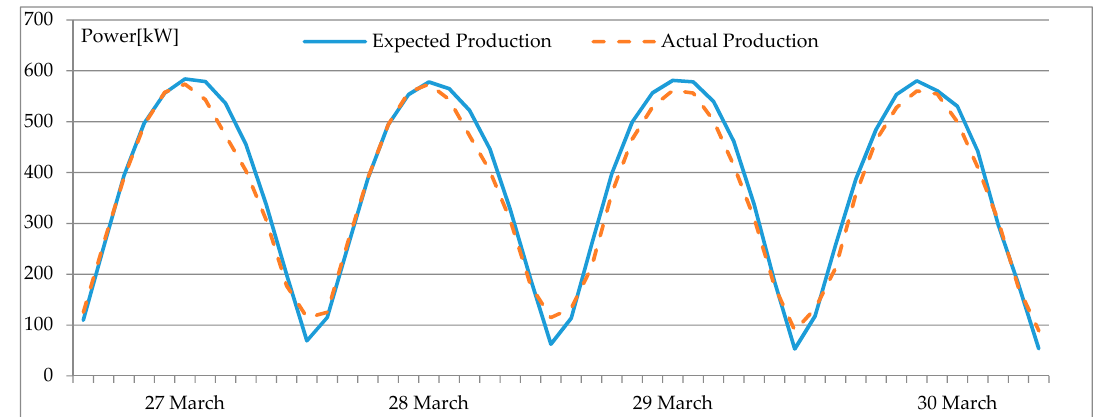
Figure 2. Clear sky forecast results; MAPE = 9.8% (mean absolute percentage error), nMAE = 2.6% (normalized mean absolute error).